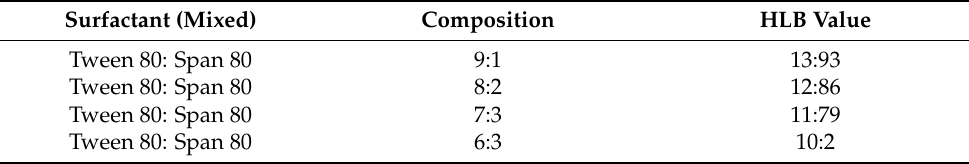
Table 1. Optimization of HLB value for tween 80 and span 80 mixture.